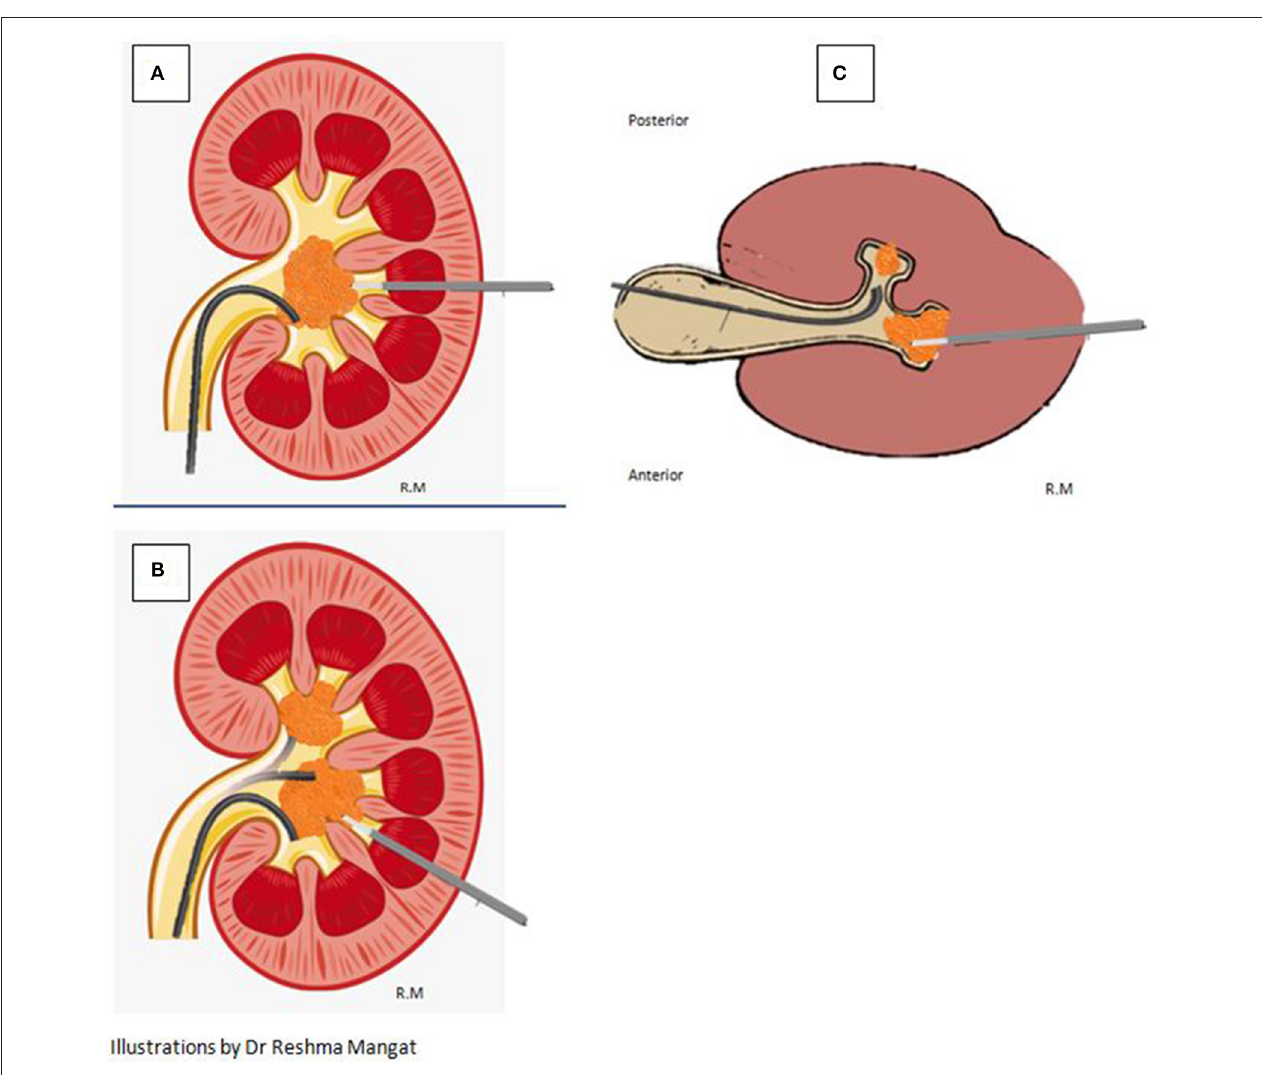
FIGURE 3 | Versatility of the micro-perc approach resulting in efficacious lithotripsy is depicted. (A) Simultaneous Antegrade and Retrograde access to the same large stone. (B) Bi-directional simultaneous access to stones in different poles of the kidney. (C) Bi-directional simultaneous access to stones in different calyces in the same pole of a